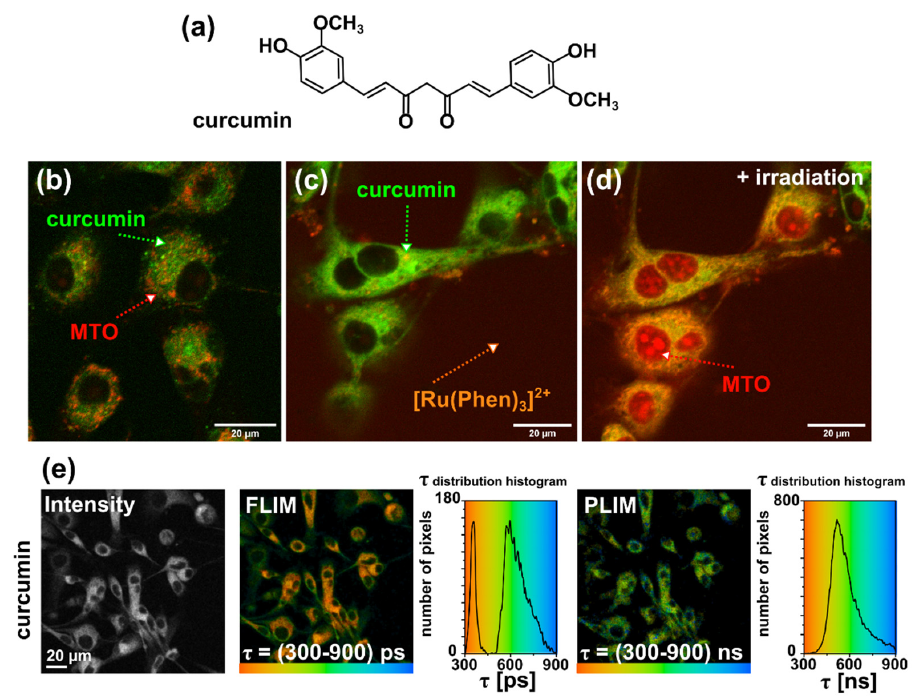
Figure 10. ( a ) Chemical structure of curcumin. Illustrative confocal microscopy fluorescence intensity images of U87 MG cells stained with ( b ) 10 µM curcumin (green) and 400 nM MTO (red), ( c ) curcumin, MTO (localized in the mitochondria), and 200 µM [Ru(Phen) 3 ] 2+ (red, extracellularly localized) first scan and ( d ) second scan that induced oxidative stress (MTO is localized in the nuclei). ( e ) FLIM and PLIM images of curcumin in U87 MG cells and corresponding fluorescence and phosphorescence lifetimes histograms. The lifetimes are color-coded (minima—red, maxima—blue). The gray-scaled image represents the fluorescence and phosphorescence intensity of curcumin.